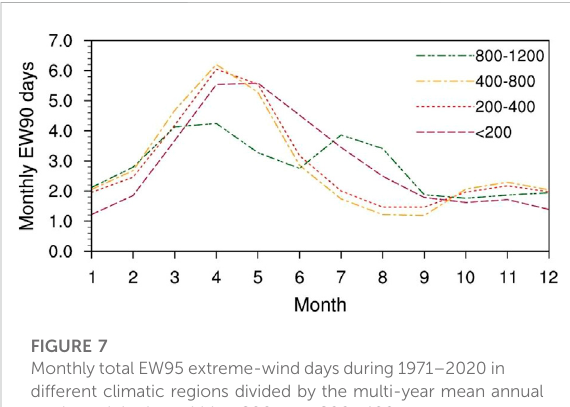
FIGURE 7 Monthly total EW95 extreme-wind days during 1971 – 2020 in different climatic regions divided by the multi-year mean annual total precipitation within < 200 mm, 200 – 400 mm, 400 – 800 mm, 800 – 1,200 mm and > 1,200